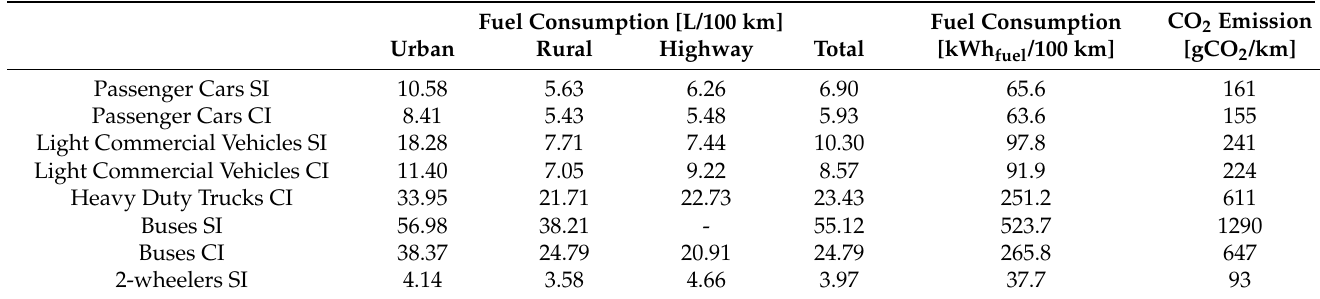
Table 1. Road transport specific fuel consumption and CO 2 emission in Italy 2019.